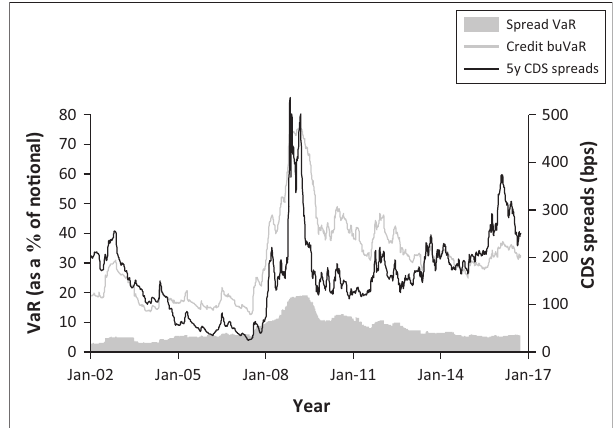
FIGURE 2: Credit risk measures on five-year credit default swap spreads using standard deviation as a measure of volatility (risk-free rate = 7.00 % , bond recovery rate = 50 % , ω = 2